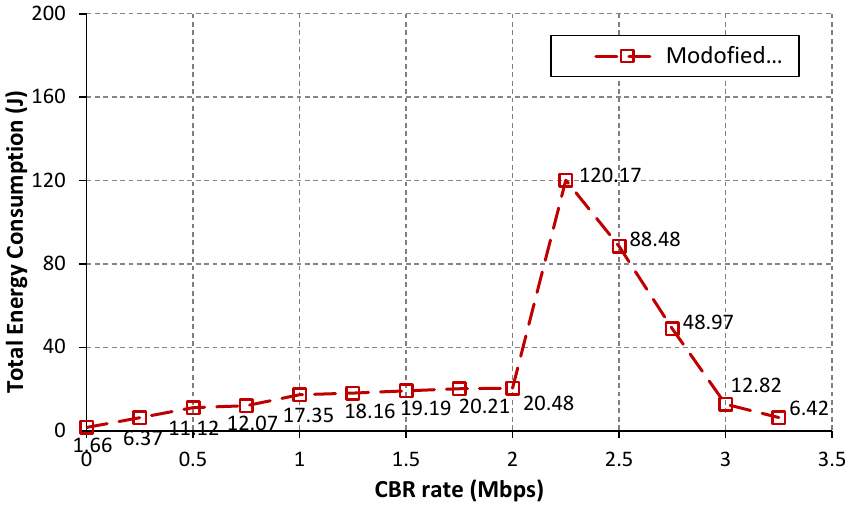
Figure 11. Energy consumption at each window interval vs . CBR rate. ( a ) Vary the CBR rates from 0 to 0.75 Mbps. ( b ) Vary the CBR rates from 1.00 to 1.5 Mbps. ( c ) Vary the CBR rates from 1.75 to 2.25 Mbps. ( d ) Vary the CBR rates from 2.50 to 3.25 Mbps.